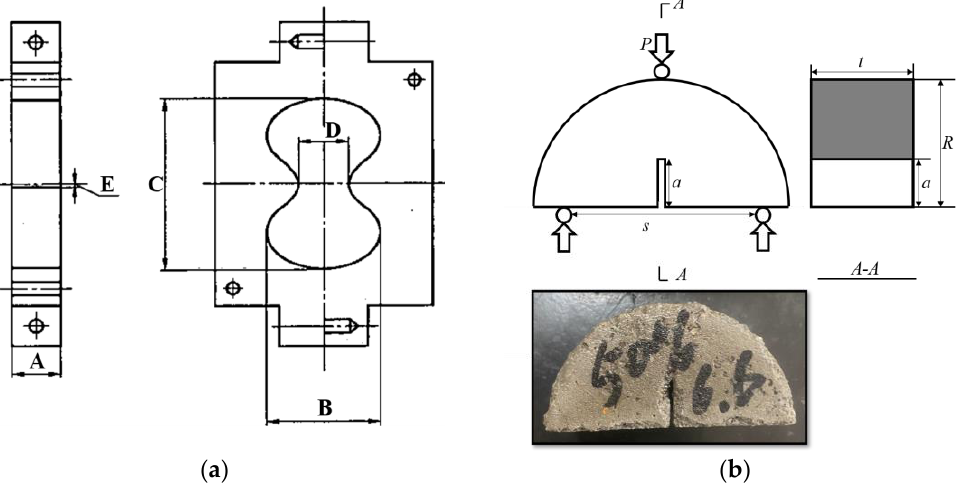
Figure 1. ( a ) the 8-shaped mold; ( b ) semicircular bend specimen.